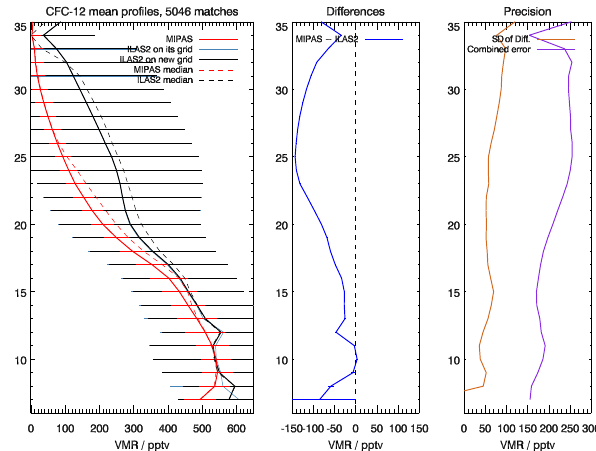
Figure 29. Comparison of mean profiles of MIPAS CFC-12 (left panel, continuous red line) and ILAS-II (left panel: blue line denotes ILAS-II on native grid; continuous black line denotes ILAS-II) for the FR period, corresponding to the MIPAS V5H_CFC-12_20 data set. The dashed lines show the median of each data set. The error bars include the total error for both instruments. The middle panel shows the mean difference (blue) of these profiles and the standard error of the mean. The right panel shows the combined error (pur- ple) of the instruments and the standard deviation of the differences